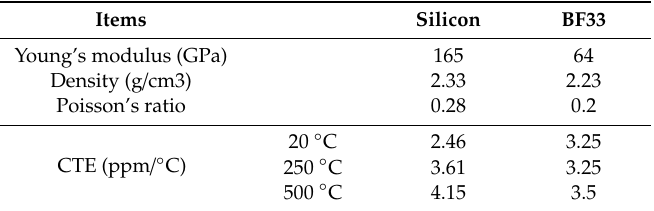
Table 1. Properties of materials used in finite element method.